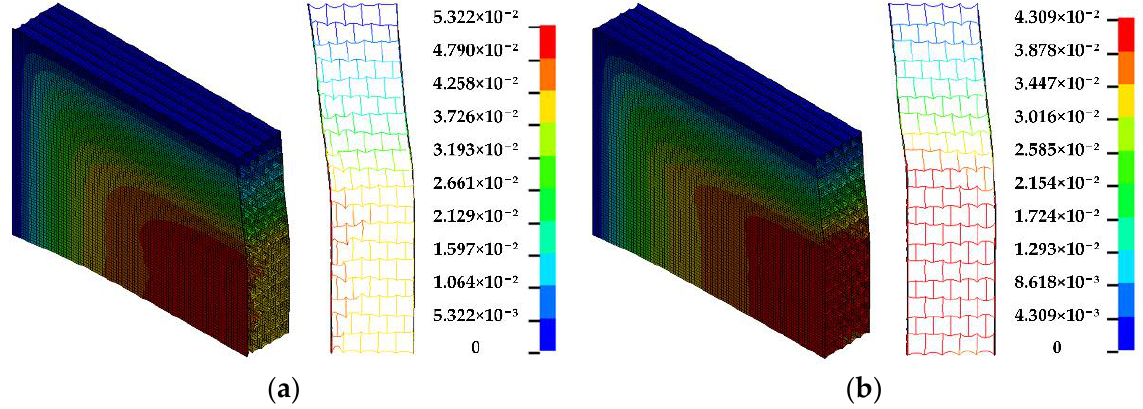
Figure 21. Deformation of different gradient. (a)Positive gradient; and (b) Negative gradient. In order to give a detailed deflection history of the positive gradient honeycomb structure and the negative gradient honeycomb structure during blast loading, the cures were plotted in Figure 22a,b. It can be seen from Figure 22a that the deformation of the front face plate and back face plate of the positive gradient honeycomb structure is quite different, which leads to the large compression deformation of the honeycomb core. In contrast, according to Figure 22b, the deformation difference between the front and back plates of the honeycomb structures with negative gradient is not large, which makes the compression deformation of the honeycomb core very